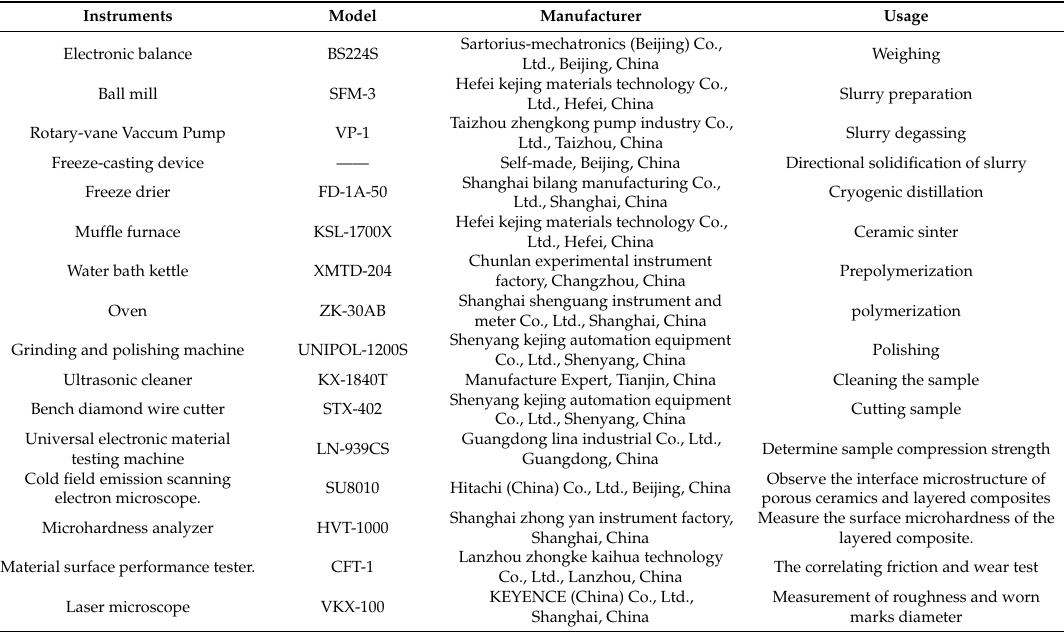
Table A1. Experiment